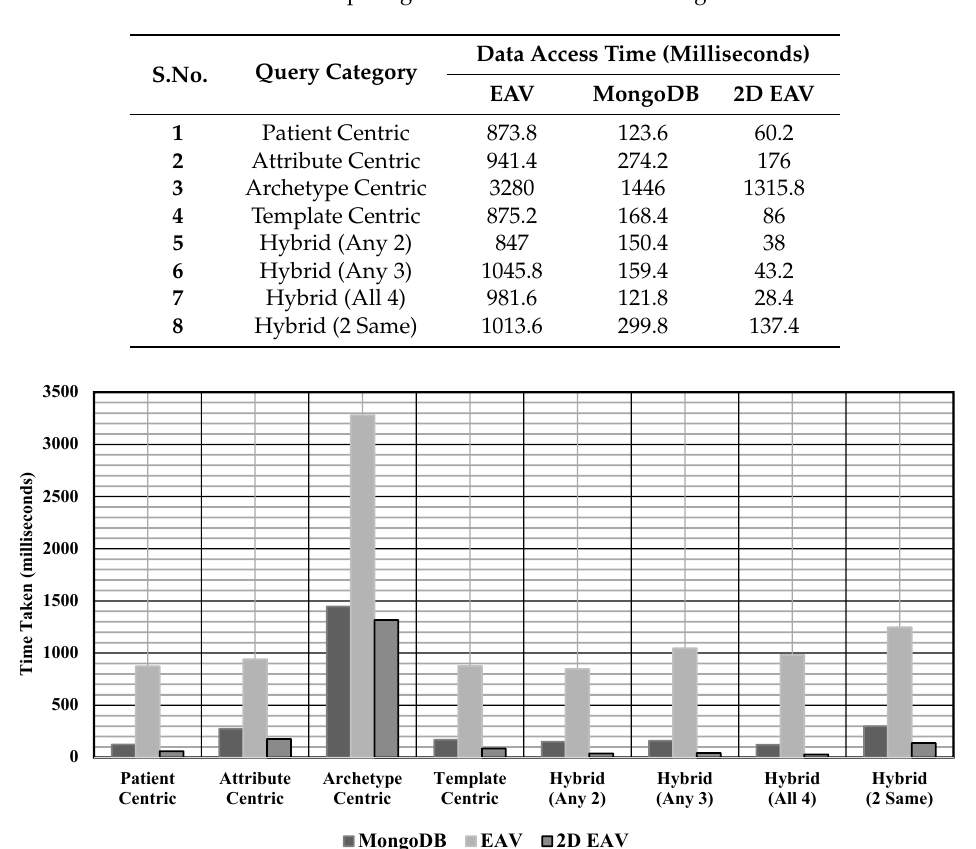
Table 3. Comparing 2D EAV with EAV and MongoDB.